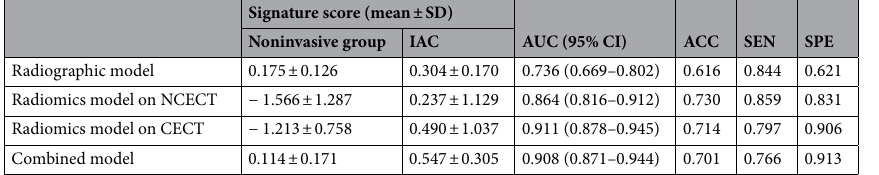
Table 2. The performance of the radiographic, radiomics and combined model in all patients. AUC area under curve; ACC accuracy; SEN sensitivity; SPE specificity; PPV positive predictive value; NPV negative predictive